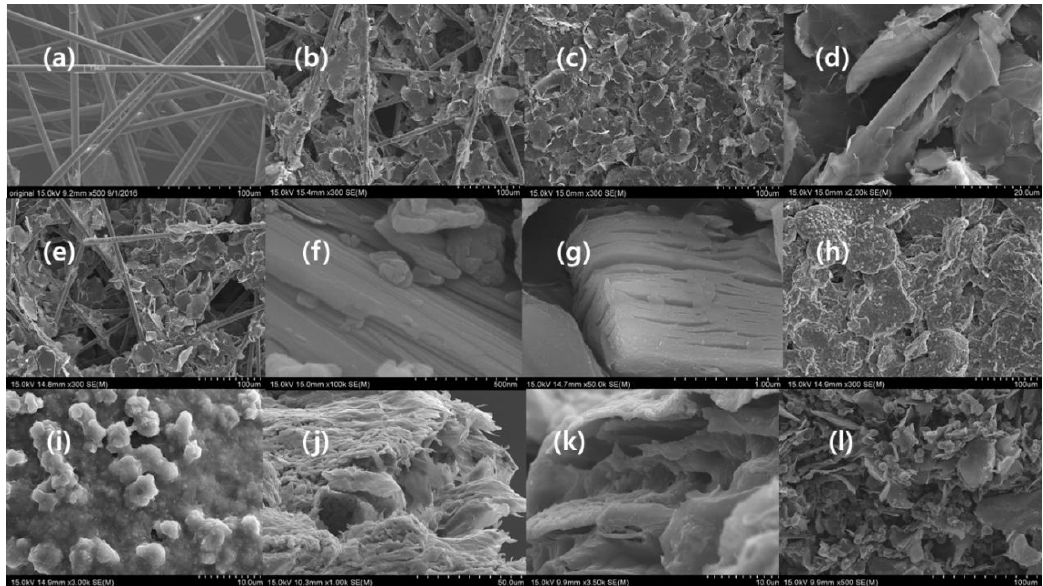
Figure 1. Microstructural images from scanning electron microscopy of ( a ) surface of MC ( × 500), ( b ) surface of GNMC ( × 300), ( c ) surface of GNOMC ( × 300), ( d ) fiber surface of GNO-coated GNOMC ( × 2000), ( e ) surface of rGNOMC ( × 300), ( f ) Ti 3 AlC 2 ( × 100,000), ( g ) Ti 3 C 2 T x ( × 50,000), ( h ) surface of MGNC ( × 300), ( i ) MXene on surface of MGNC ( × 3000), ( j ) cross-section of MGNC ( × 1000), ( k ) cross-section of MGNC ( × 3500) ( l ) cross-section of MGNOC ( × 500).